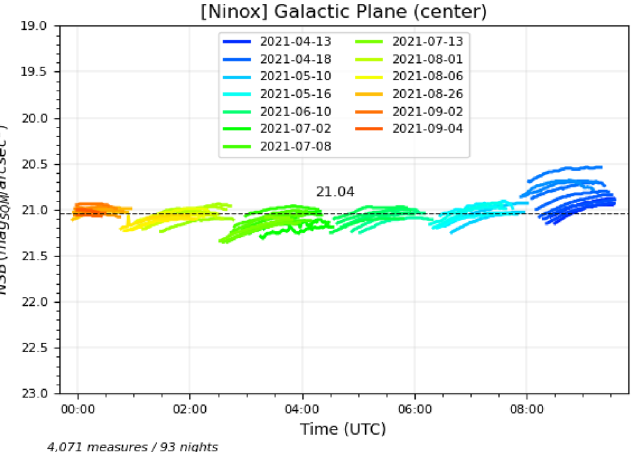
Figure 4. Measures obtained during moonless nights with good clear sky conditions where galactic latitude of the zenith is between − 10 ◦ and + 10 ◦ and galactic longitude between 355 ◦ and 5 ◦ . This corresponds to situations where the Sagittarius and Scorpius constellations, i.e. the Galactic center, are at the zenith.